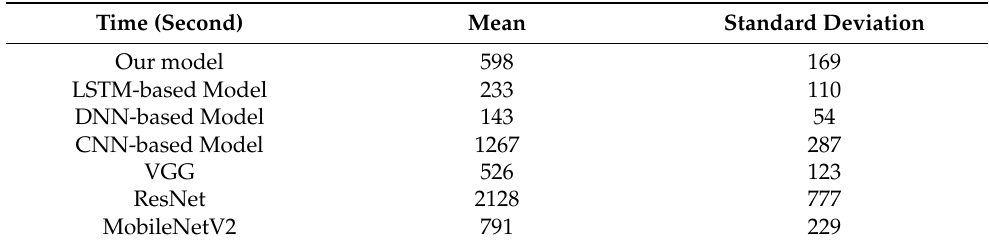
Table 5. The simulation time among different prediction models. Time